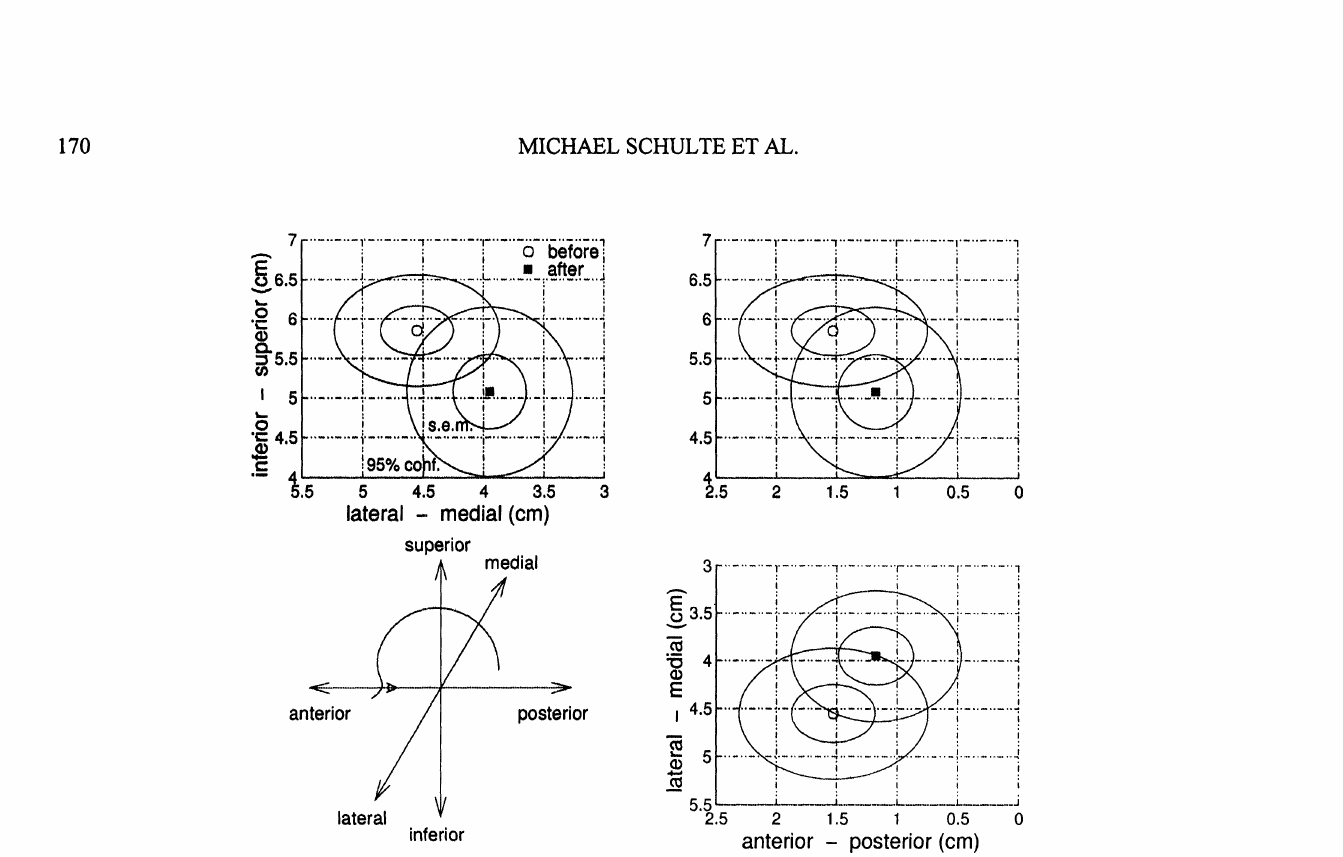
Fig. 4" Mean GBR source locations before and after exposure collapsed over all subjects and both hemispheres. The inner circles illustrate s.e.m, and the outer circles denote the corresponding 95% confidence intervals.